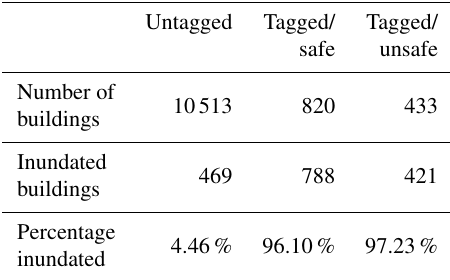
Table 2. RESA tags and inundated buildings in the study area fol- lowing the February 2019